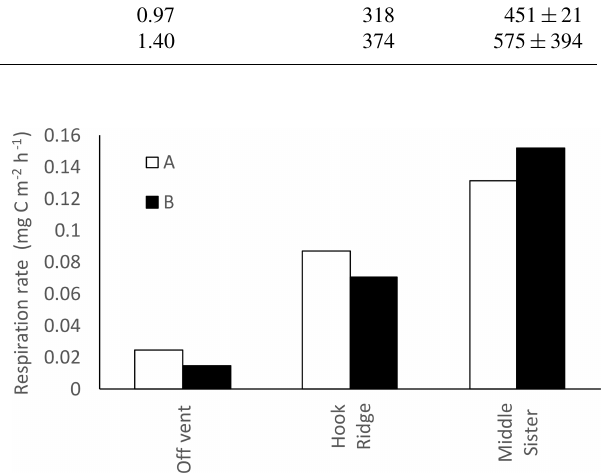
Table 1. Site characteristics, all of the information except that on bacterial biomass is from Bell et al. (2016b). Site Latitude Longitude Depth Temperature Sediment wt%C org Macrofaunal Biomass Bacterial Biomass (m) ( ◦ C) in 0–1cm horizon Off Vent